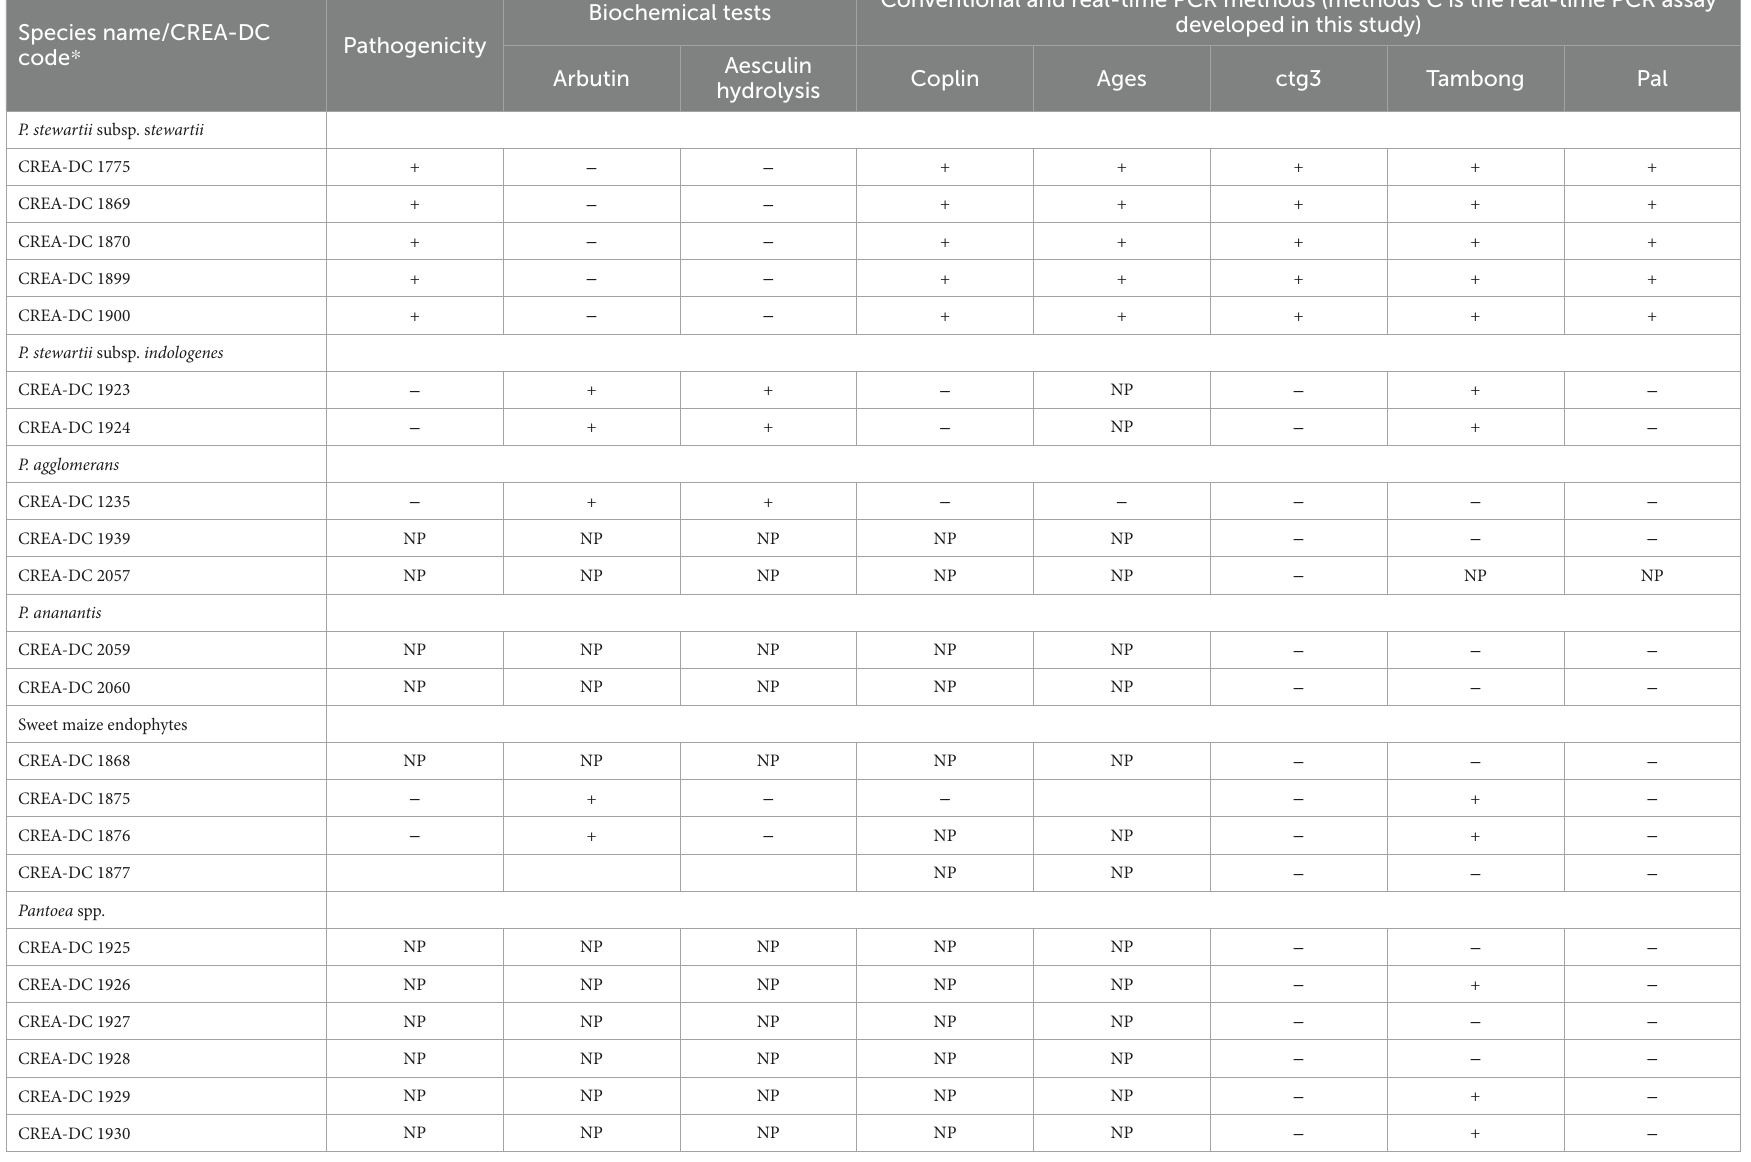
TABLE 5 Results of analytical specificity and biochemical and pathogenicity